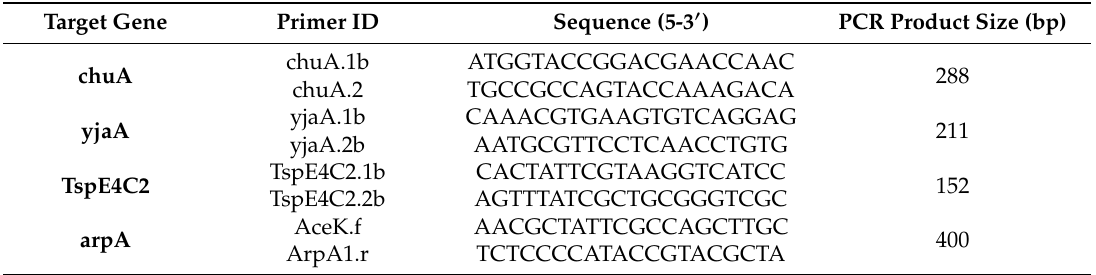
Table 1. Primer sequences and sizes of amplicons employed in the phylo-grouping experiment.